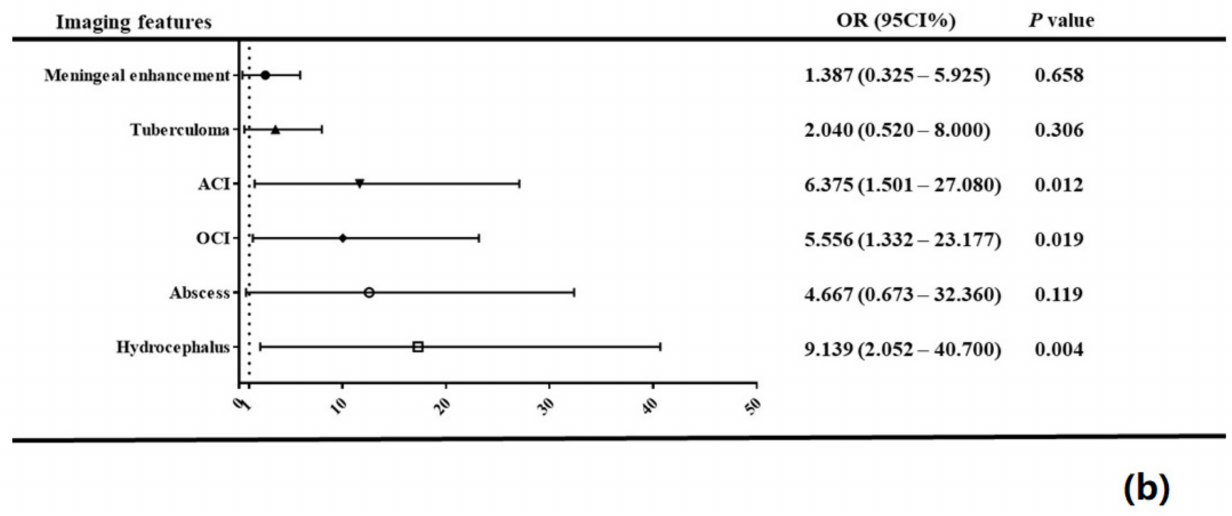
Figure 2. The MRI features as the risk factors for assessing neurological deficits ( a ) and poor prognosis ( b ) in TBM patients.